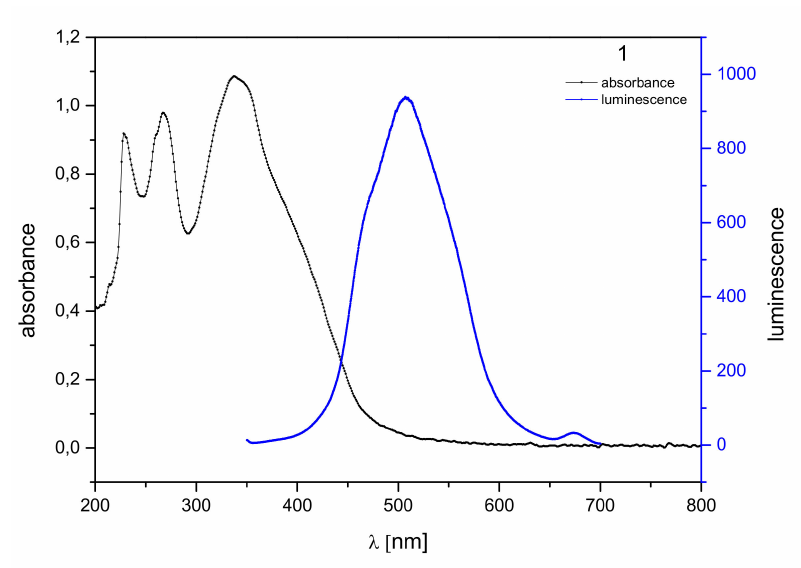
Figure 1. Normalized absorption spectra (black) and emission spectra (blue) of 1 in dichloromethane solution (10 − 6 mol / dm 3 ).